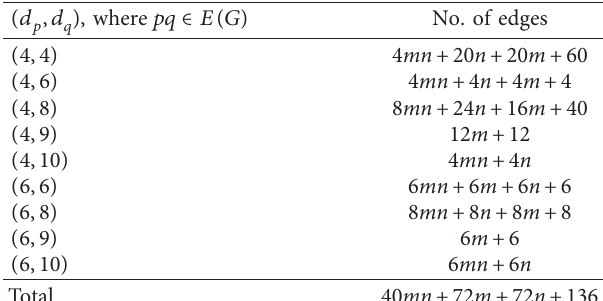
Table 2: The vertex division of degree-based topological indices of ( m , n ) Robertson apex